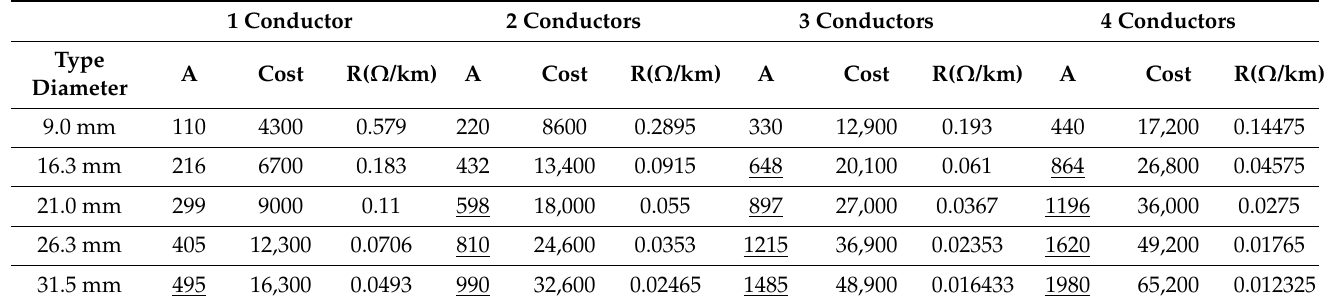
Table 2. Different types of conductors. Current rating (A) (summer, no wind); Conductor cost ($ per km); and resistance value R ( Ω /km).